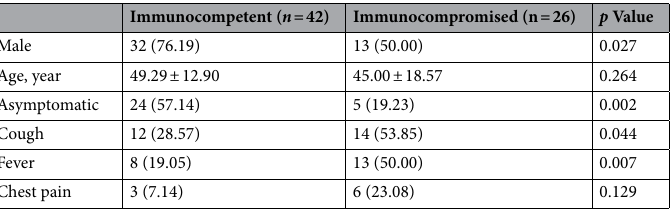
Table 1. Comparison of demographics and clinical symptoms of patients with PC in the immunocompetent group and immunocompromised